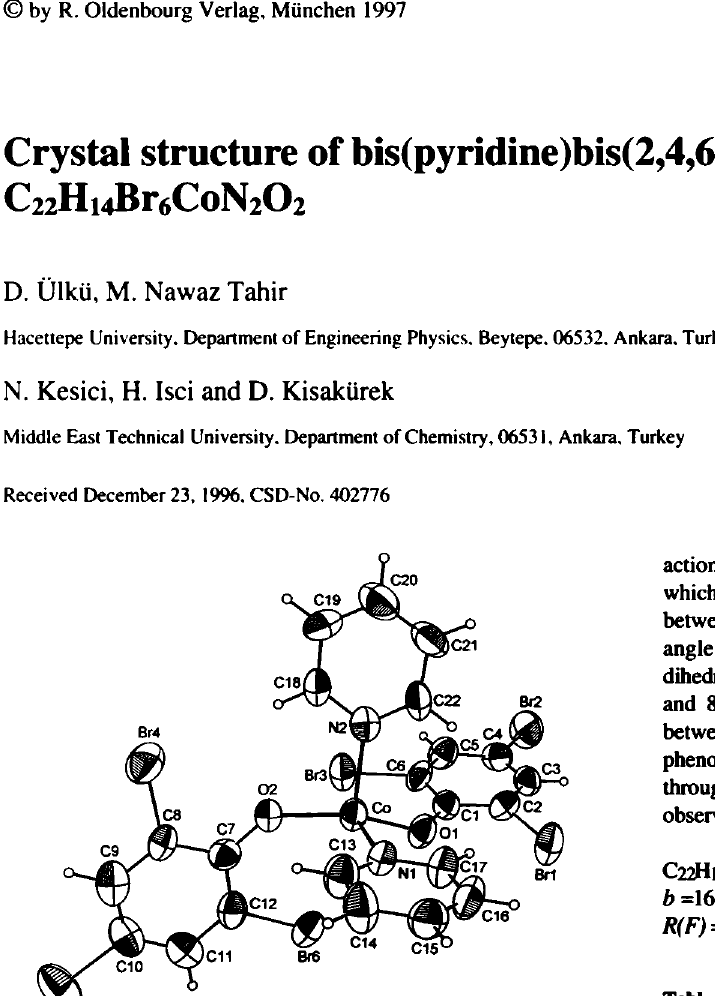
Table 1. Parameters used for the X-iay data collection Crystal: